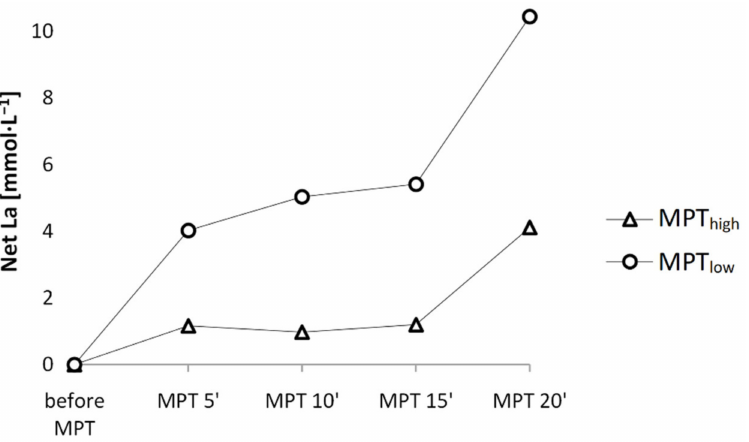
Figure 4. Net [La] increase during